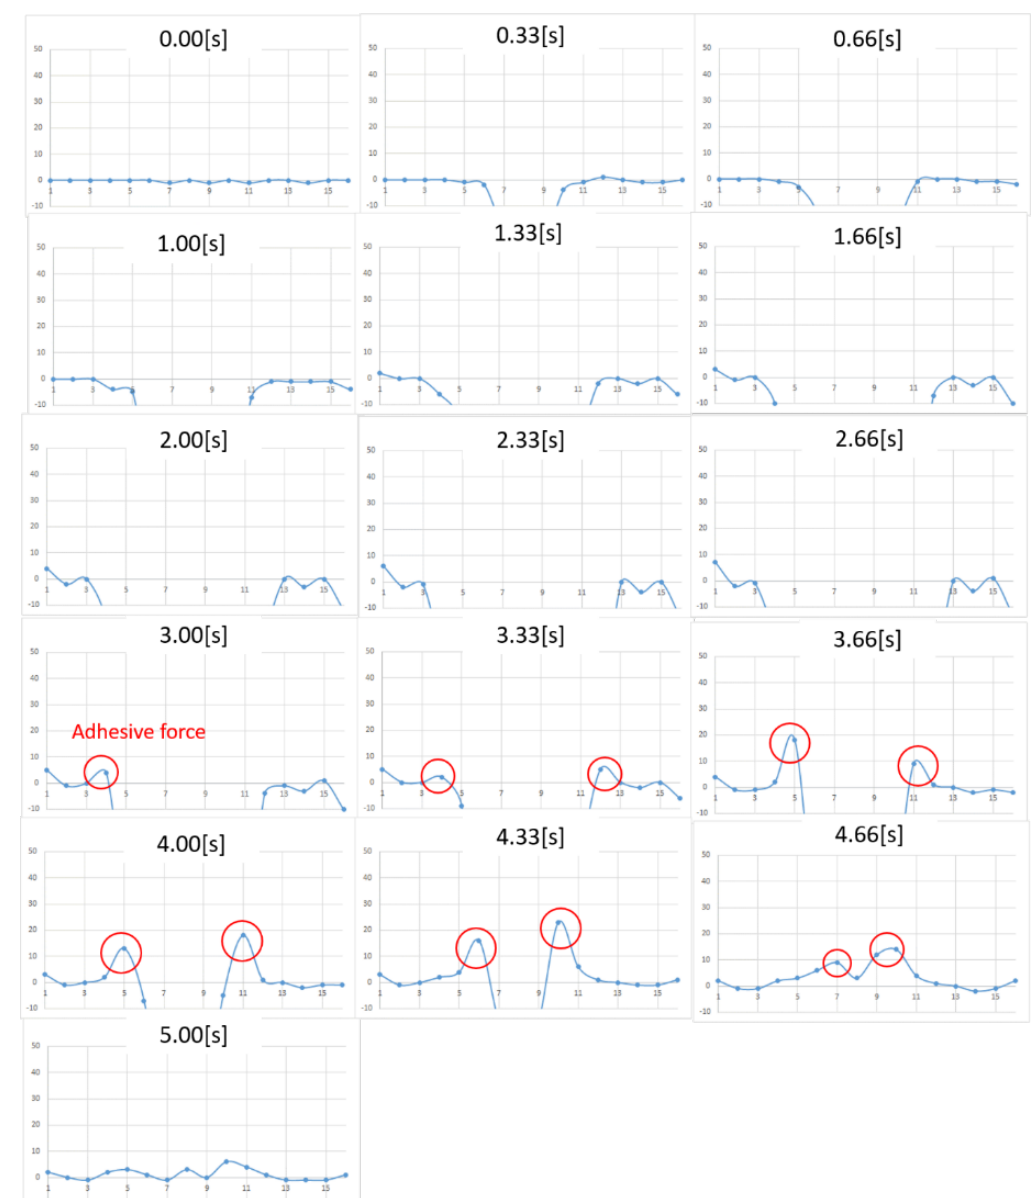
Figure 12. Change in pressure distribution for honey. The vertical axis represents the force (in milli newton). The horizontal plane represents the location of the sensing point.